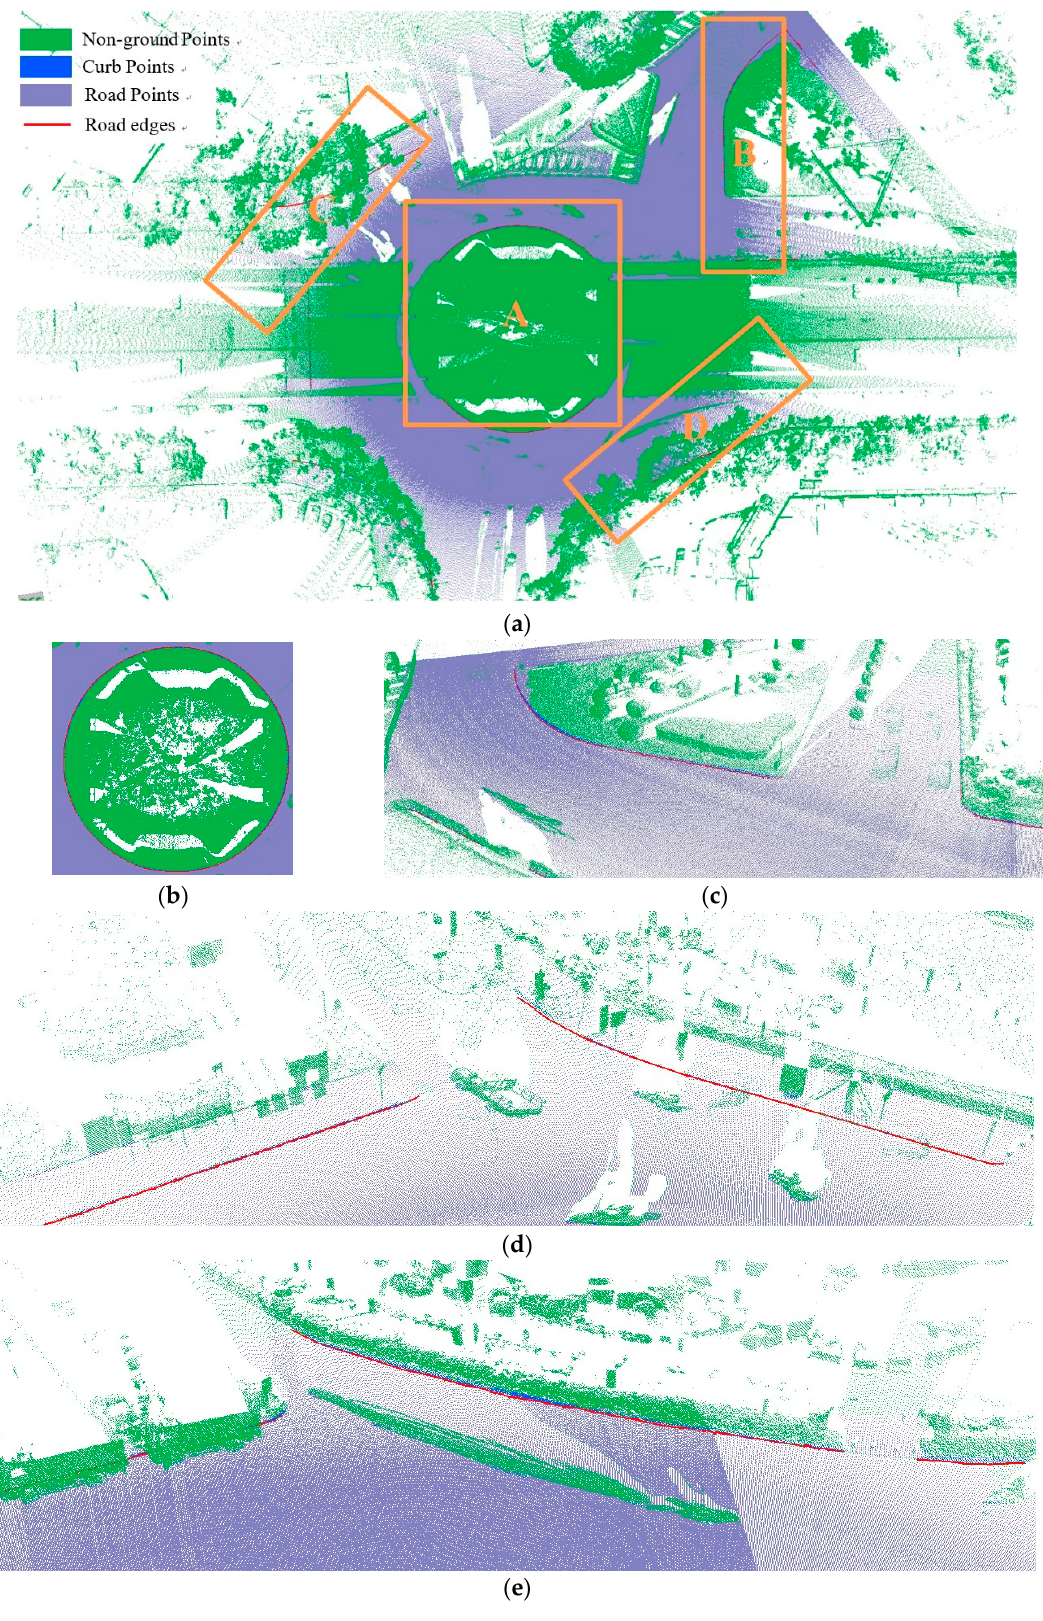
Figure 10. Extraction results based on the proposed method. ( a ) Extraction result; ( b ) Sample A; ( c ) Sample B; ( d ) Sample C; ( e ) Sample D.